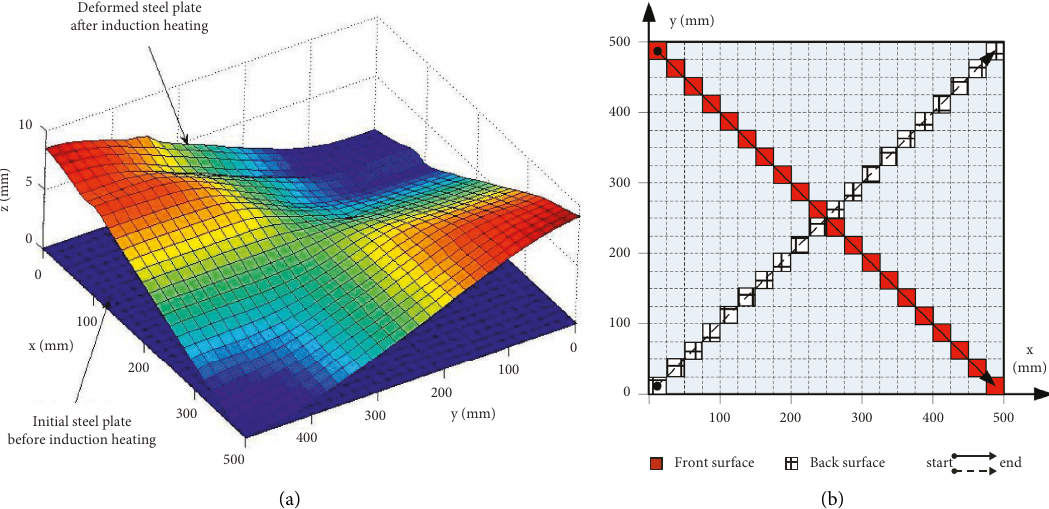
Figure 10: Measurement results: (a) wavy transformation on square plate and (b) predicted regions and its relative surface.